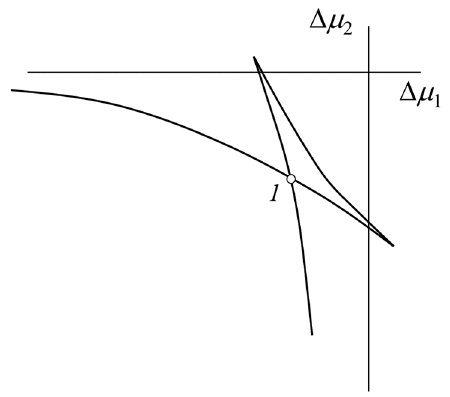
Figure 3. Graphical representation for the self-intersection point (1) of the concentration dependences of the chemical potentials.